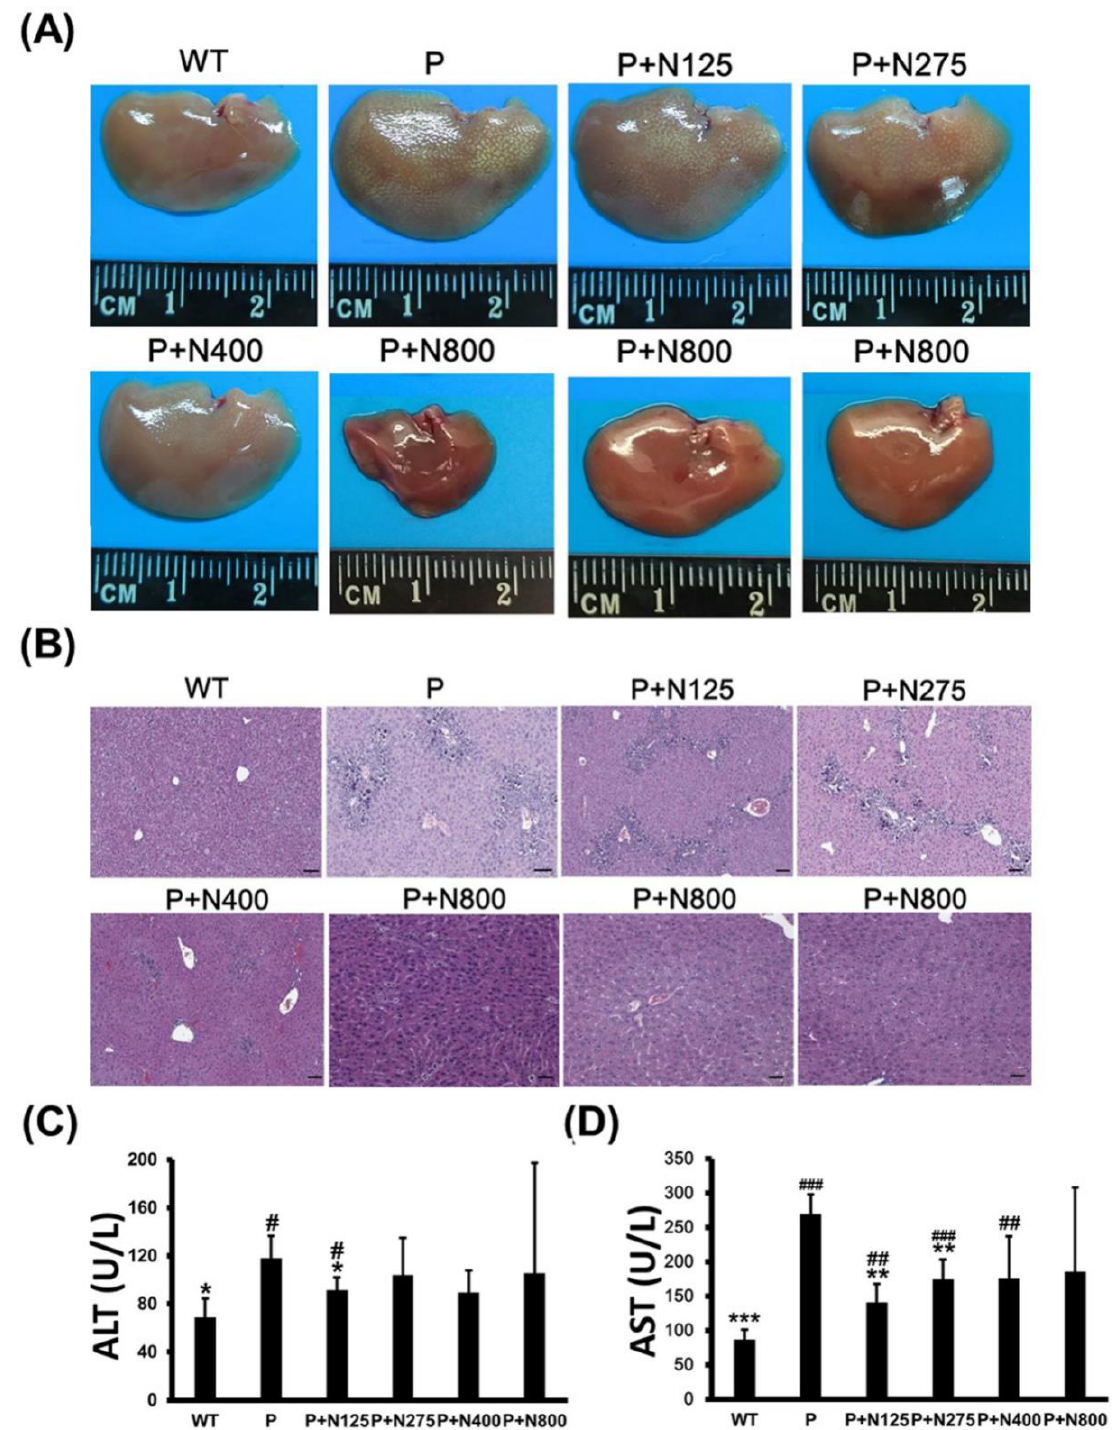
Figure 2. Different NAC doses rescued 1200 mg/kg propacetamol (P)-induced toxicity in BALB/c mice at 7 days. Liver appearances ( A ), histopathological images of liver sections ( B ), and serum alanine aminotransferase (ALT) ( C ) and aspartate aminotransferase (AST) ( D ) activities in surviving mice in indicated groups. Significant differences compared with the P group are indicated by * (p < 0.05), ** (p < 0.01), and *** (p < 0.001). Significant differences compared with the PBS treatment group (WT) group are indicated by # (p < 0.05), ## (p < 0.01) and ### ( p < 0.001). Scale bars: 50 μm.